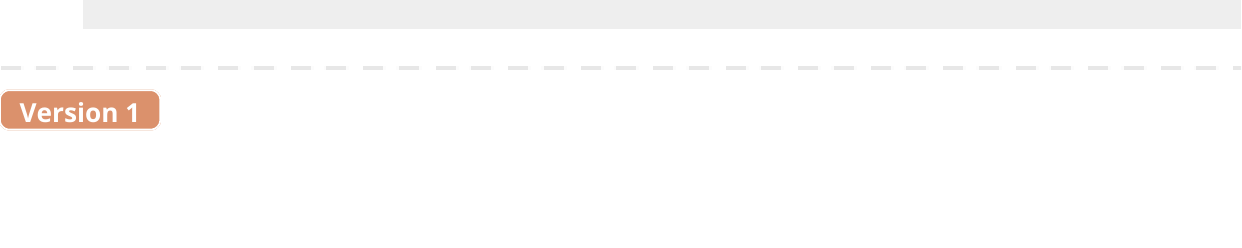
Figure 2: Minor comments – the text “ Map on salmon genes ” is vague and open